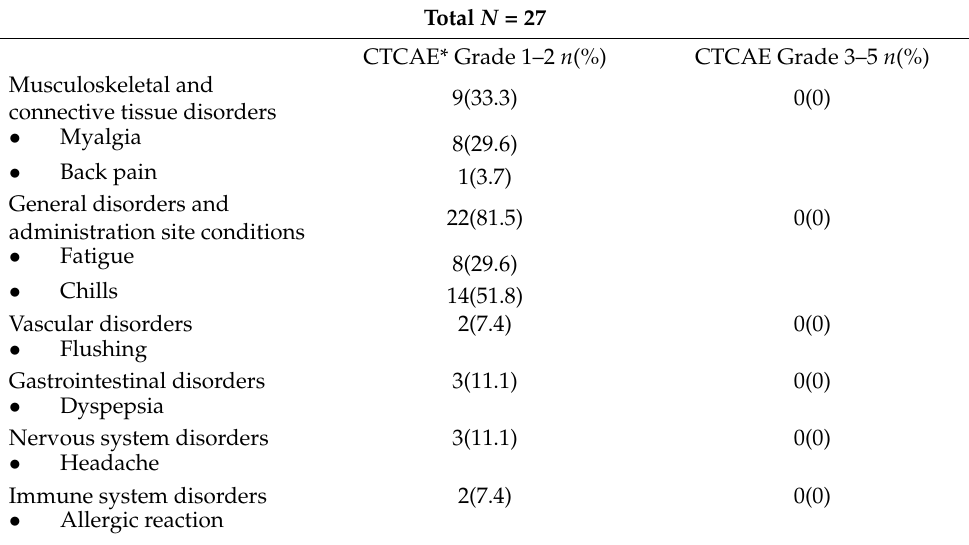
Table 3. Adverse